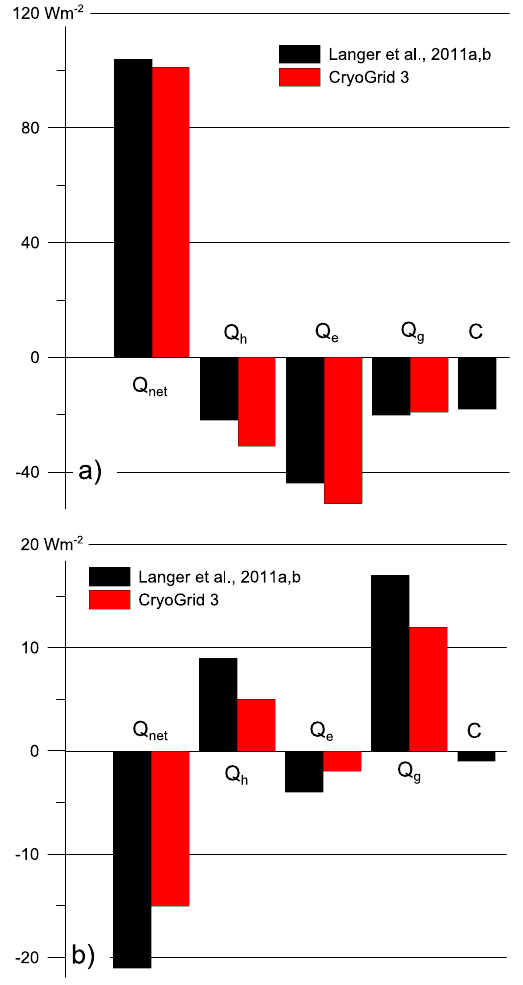
Figure 3. Modeled and measured average surface energy balance for (a) the summer period 7 Jun to 30 Aug 2008 and (b) the winter period 1 December 2007 to 30 Jan 2008, as documented in Langer et al. (2011a, b). Shown are the net radiation ( Q net ), sensible, latent, and ground heat flux ( Q h , Q e , Q g ), and the residual of the surface energy balance C (0 in the model). The modeled fluxes are taken from the validation run with low snow density (200kgm − 3 ), the values for the high snow density agree within 2Wm − 2 . The mea- sured fluxes correspond to Fig. 9 in Langer et al. (2011b).